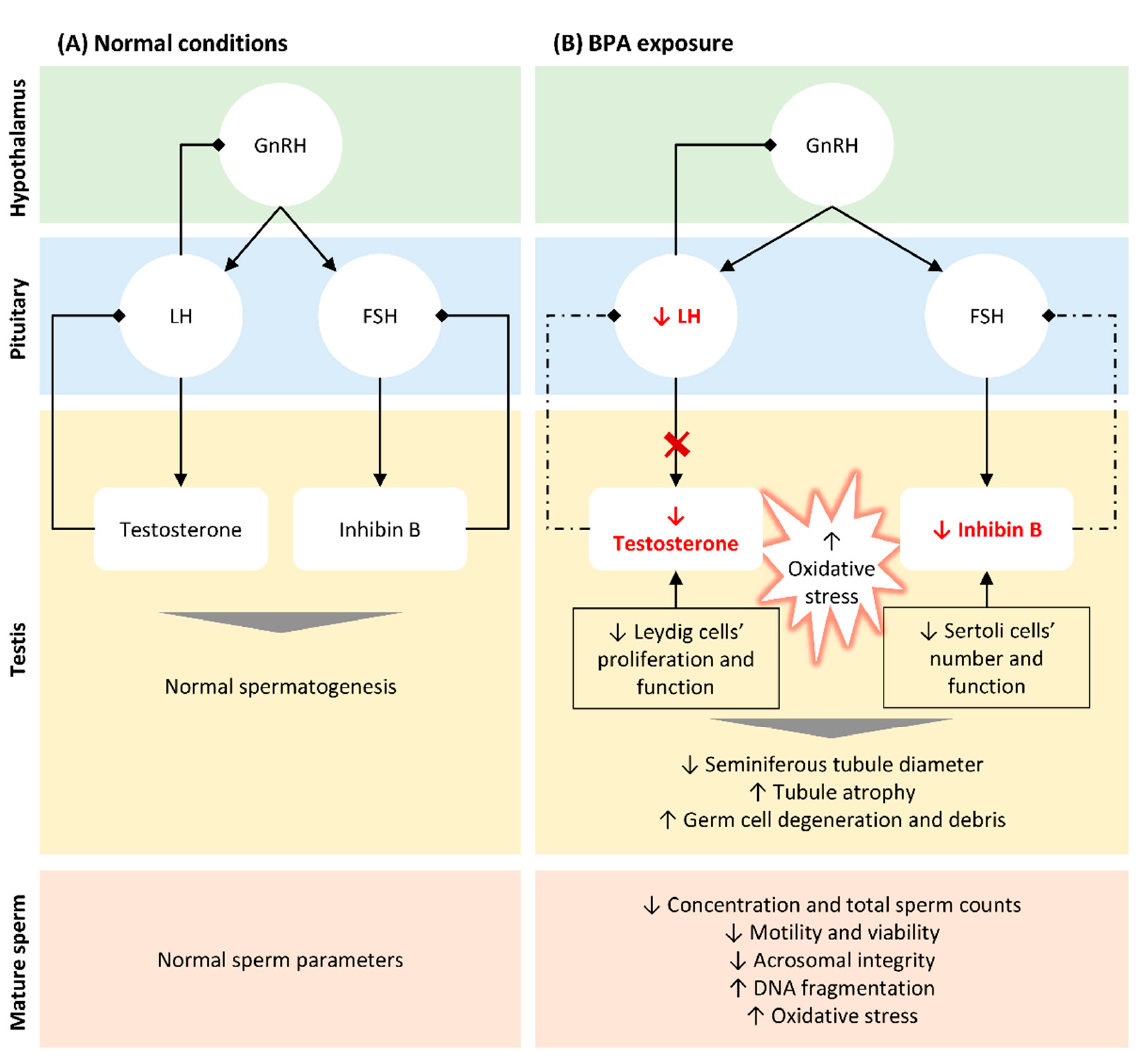
Figure 1. Schematic representation of BPA-induced alterations in hypothalamic–pituitary–testicular (HPT) axis, testicular function and structure, and in seminal parameters. ( A ). In normal conditions, gonadotrophin releasing hormone (GnRH) is released by the hypothalamus stimulating the secretion of follicle-stimulating hormone (FSH) and luteinizing hormone (LH) by the pituitary. LH acts on Leydig cells and FSH on Sertoli cells, stimulating the biosynthesis of testosterone and inhibin B, respectively. Both hormones are crucial for normal spermatogenesis and, thus, to produce normal sperm. When testosterone and inhibin are released in the bloodstream, they inhibit GnRH/LH and FSH secretion, respectively (negative feedback). ( B ). Even at low concentrations, BPA reduced the levels of testosterone by directly targeting Leydig cells, reducing their proliferation, and impairing normal steroidogenesis. Moreover, BPA indirectly suppresses the release of LH through aromatase upregulation in testis, blocking testosterone synthesis. The reduction of inhibin B observed following BPA exposure is also associated to a reduction in the number of Sertoli cells, directly affecting spermatogenesis. The lower levels of testosterone and inhibin B block the mechanism of negative feedback, in an attempt to increase the release of LH and FSH and their action in testis (dashed arrows). BPA exposure also results in an increase in free radicals, which associated with altered hormonal levels lead to histological alterations in testis and germ cells’ reduction and degenerations. These alterations explain the abnormal seminal parameters observed in situations of BPA exposure, such as decreased concentration and total sperm count, reduced motility and viability and increased DNA fragmentation.